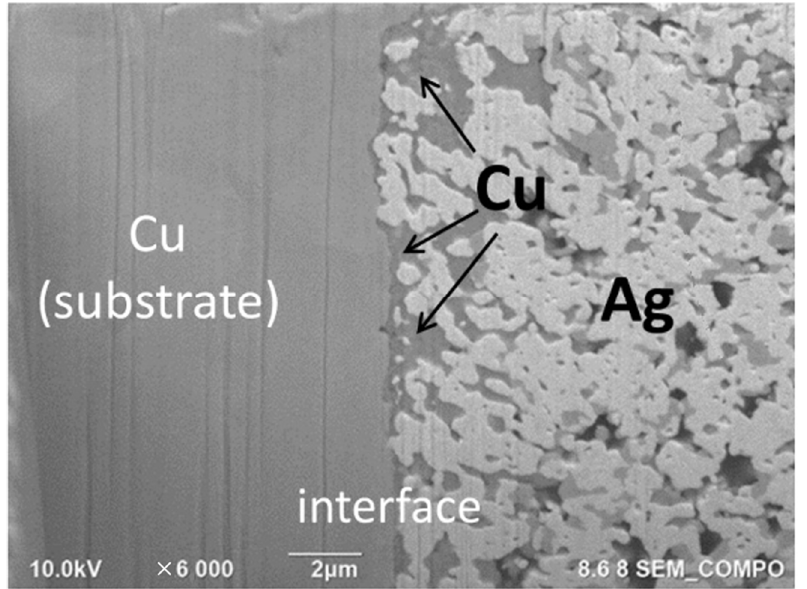
Figure 10. Cross-sectional LNCP(EC)/Cu joint microstructure from another location of the LNCP(EC)/Cu substrate joint (segregated Cu regions are indicated).